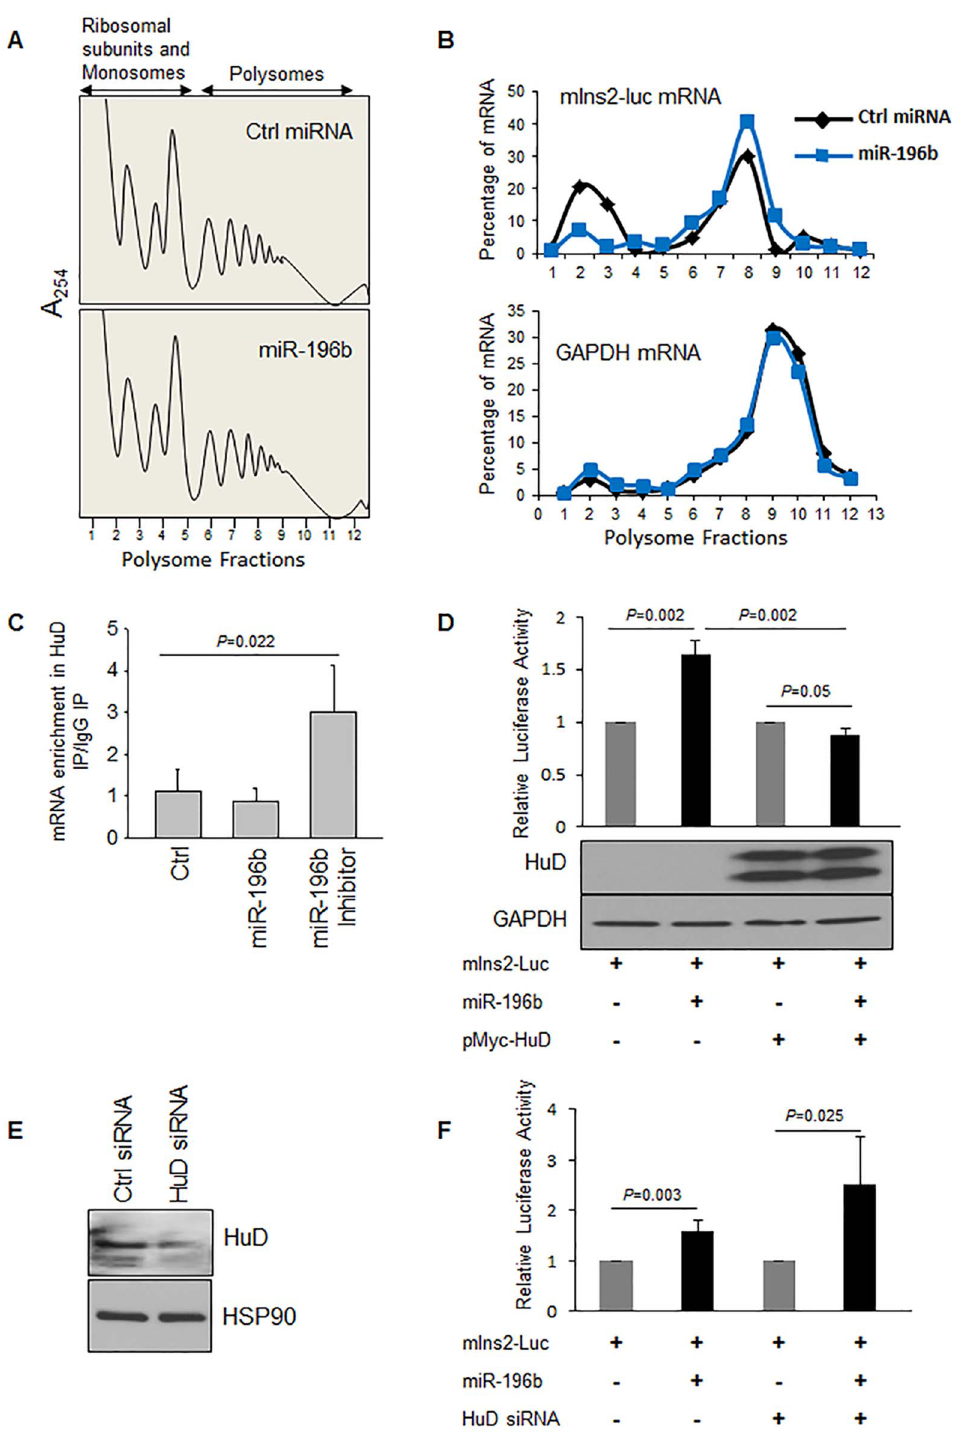
Figure 4. miR196b induces polysome association of Insulin2 reporter mRNA by inhibiting HuD binding. ( A ) Lysates prepared from b TC6 cells transfected with Ctrl miRNA or mature miR-196 were fractionated through sucrose gradients to generate polysome profiles. Fractions 1–5 and 6–12 were considered as non-polysome and polysome respectively. ( B ) The relative distribution of Insulin2 reporter mRNA and GAPDH mRNA on polysome gradients was studied by RT-qPCR analysis of the RNA present in each of 12 gradient fractions, and represented as percentage of total mRNA. One of the representative experiments is shown here. ( C ) Interaction of HuD with Ins2-reporter mRNA in b TC6 cells transfected with control, mature miR-196b or miR-196b inhibitor, was studied by mRNP IP analysis using anti-HuD or control IgG antibodies. The RNA in the IP material was isolated, and Ins2 -reporter mRNA levels were measured by RT-qPCR analysis and normalized to PGK mRNA levels. ( D ) Translation upregulation of insulin2 reporter with miR-196b in HEK293T cells transfected with either control or Myc-HuD plasmid. Lower panel shows the immunoblot for the over expression of Myc-HuD. ( E, F ) Forty-eight hours after transfection of b TC6 cells with Ctrl siRNA or HuD siRNA, HuD silencing was assessed by western blot analysis (E). Luciferase reporter with insulin2 5 9 UTR along with miR-196b or control miRNA duplex was introduced into b TC6 cells